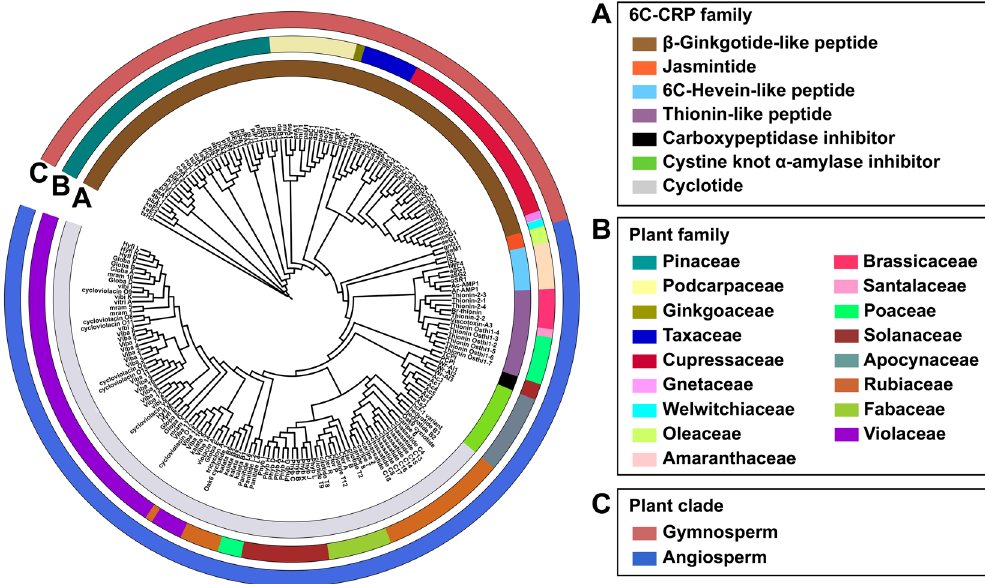
Figure 6. Phylogenetic tree of β -ginkgotide β -gB1, β -ginkgotide-like peptides and other reported CRPs with six cysteine residues. The precursor sequences β -gB1, β -ginkgotide-like peptides, jasmintides, 6C-hevein-like peptides, thionins, carboxypeptidase inhibitors, cystine knot α -amylase inhibitors and cyclotides were aligned by Kalign and the phylogenetic tree was generated by iTOL. Classification based on ( A ) the number of cysteine residues in the mature domain, ( B ) plant’s family and ( C ) plant’s clade.